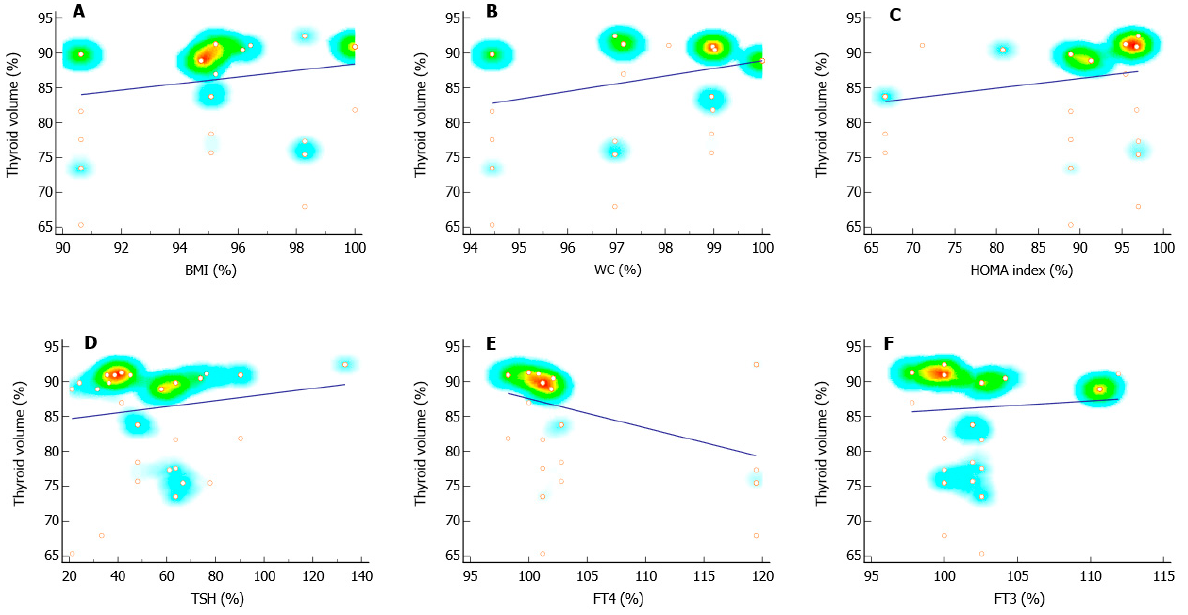
Figure 3. Scatter plots and regression lines of the thyroid volume ratio. Panels ( A – C ) show the distribution and regression line of the thyroid volume ratio (%) and the ratio of the body mass index (BMI) ( A ), the waist circumference ( B ), and the homeostatic model assessment (HOMA) index ( C ). Panels (D – F ) show the distribution and regression line of thyroid volume ratio (%) and the ratio of thyroid-stimulating hormone (TSH) ( D ), thyroxine (FT4) ( E ), and free-triiodothyronine (FT3) ( F ). The ratio of each variable was calculated using the following formula: [(after value/before value) × 100]. Table 2. Multiregression analysis of thyroid volume.